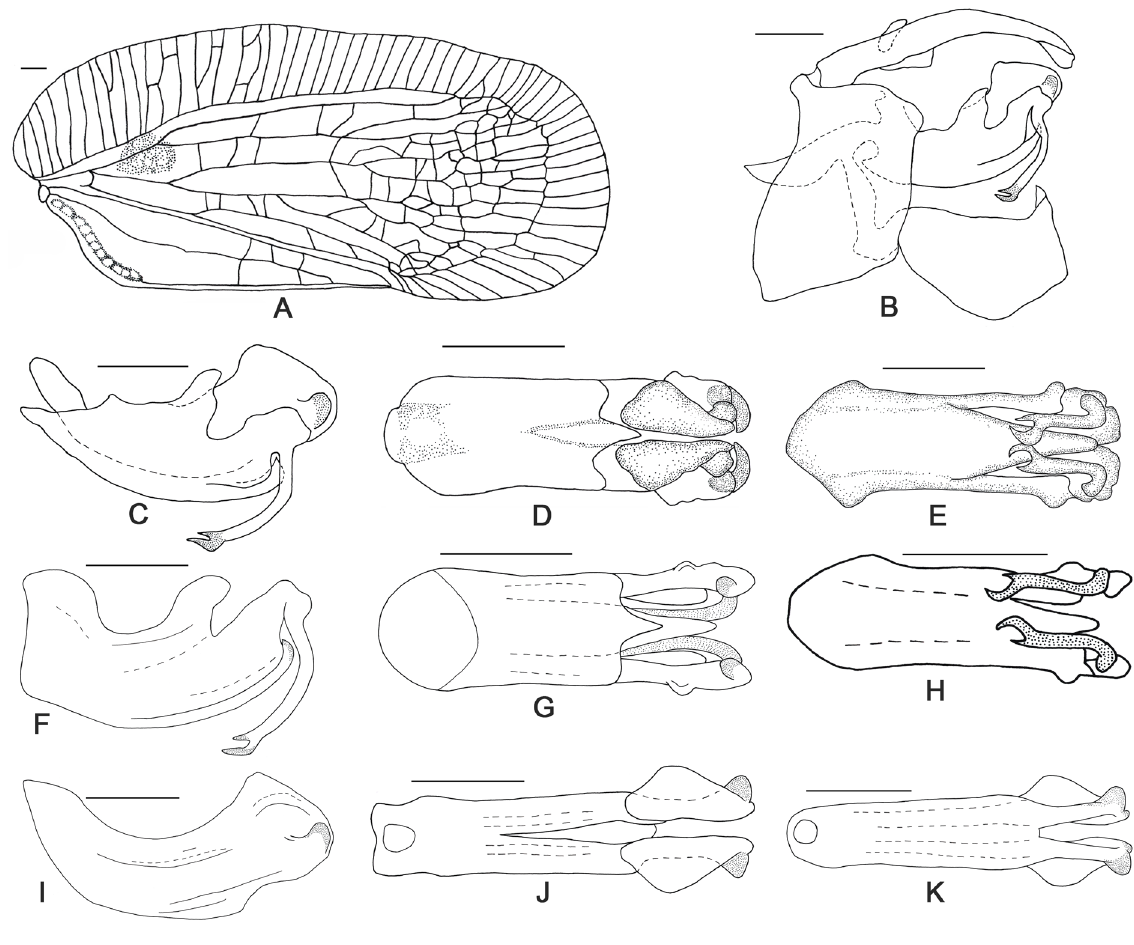
Fig. 12. Atracis ungulata sp. nov. A . Tegmen. B . Male genitalia, right lateral view. C . Phallic complex, right lateral view. D . Phallic complex, dorsal view. E . Phallic complex, ventral view. F . Periandrium, right lateral view. G . Periandrium, dorsal view. H . Periandrium, ventral view. I . Aedeagus, right lateral view. J . Aedeagus, dorsal view. K . Aedeagus, ventral view. Scale bars = 0.5